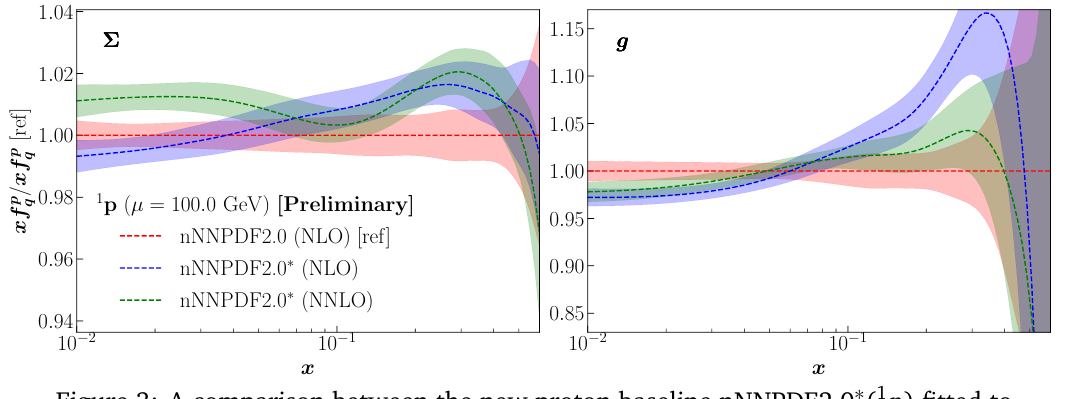
Figure 3: A comparison between the new proton baseline nNNPDF2.0 ∗ ( 1 p ) fitted to the ATLAS and CMS dijet at 7 and 8 TeV and the old nNNPDF2.0 proton